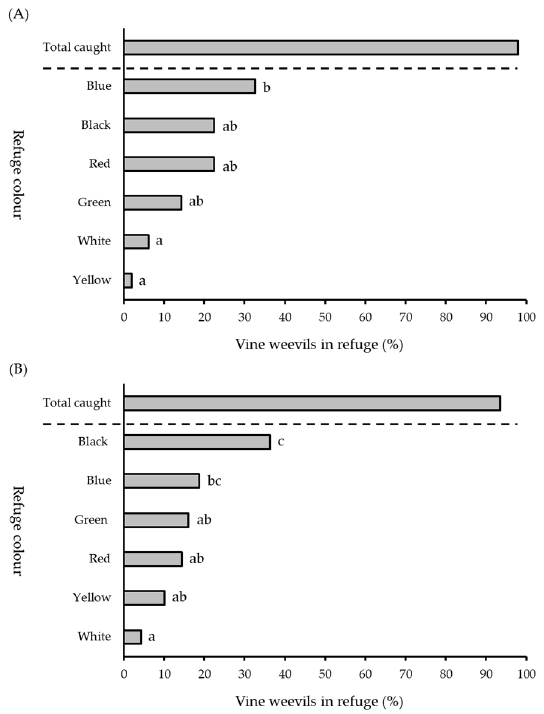
Figure 4. Percentage of vine weevil adults recorded in refuges painted blue, green, red, yellow, black or white when released ( A ) individually ( number of replicate days = 10) or ( B ) as a group of ten individuals ( number of replicate days = 5). Different letters denote significant differences between means ( p < 0.05).